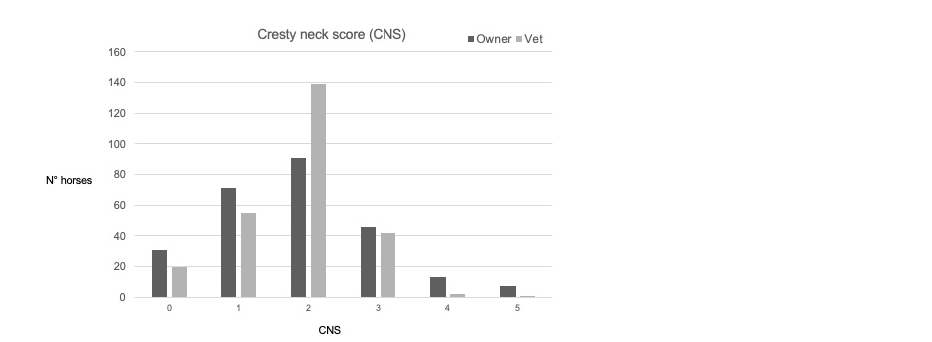
Figure 3. Data regarding the distribution of CNS in a scale from 0 to 5 performed by the owners or by the expert observer (vet) for all 259 horses included in this study. Legend: CSN—Cresty Neck Score [18].